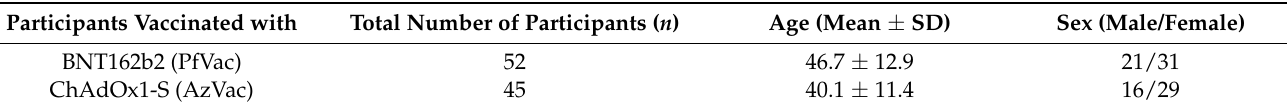
Table 1. Characteristics of study